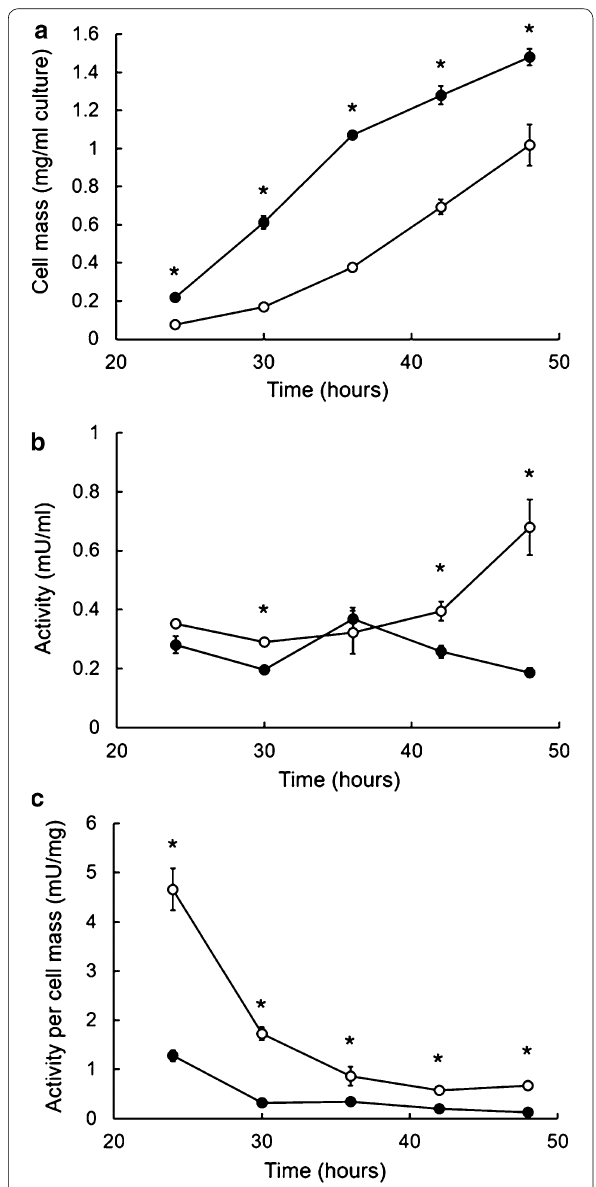
Fig. 4 Time courses of dry cell mass accumulation and DyP activity at the early stage of culture with 100 μM alizarin. Open and closed symbols denote with and without alizarin, respectively. a Dry cell mass; b DyP activity per milliliter culture broth; c DyP activity per milligram dry cell mass. Data are presented as mean *P < 0.05, unpaired two-tailed t test)